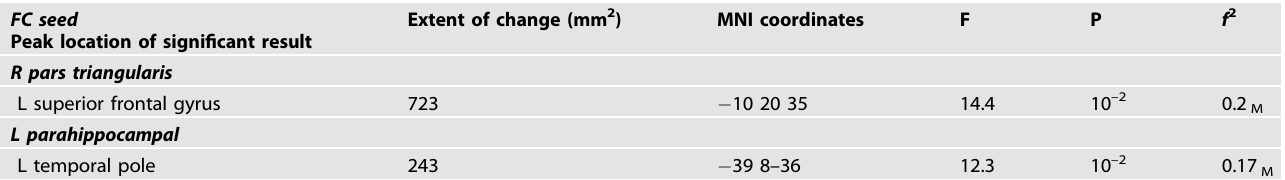
Table 3. Effects of global A β load on the relationship between cortical myelin content and rs-FC. FC seed Peak location of signi fi cant